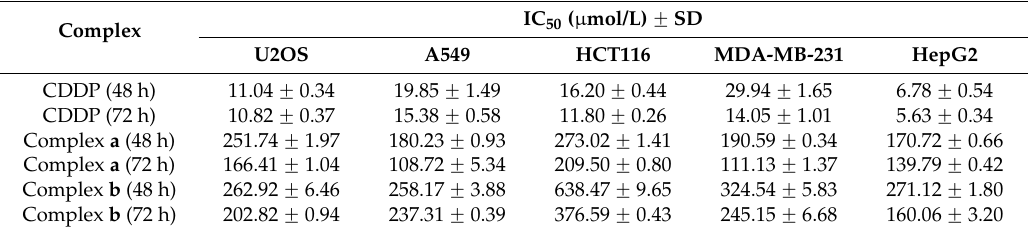
Table 1. IC 50 values of complexes a / b and CDDP against five human cancer cell lines.